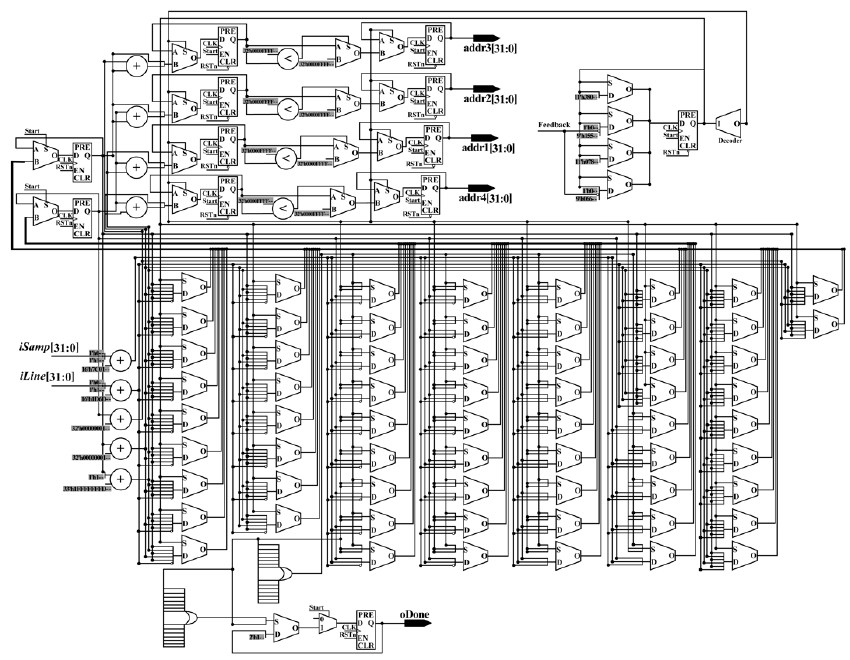
Figure 12. Schematic diagram of the get_gray_addr_mod module.